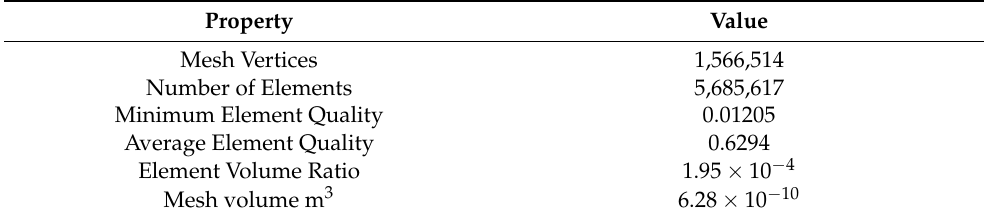
Table 3. Numerical model detailed